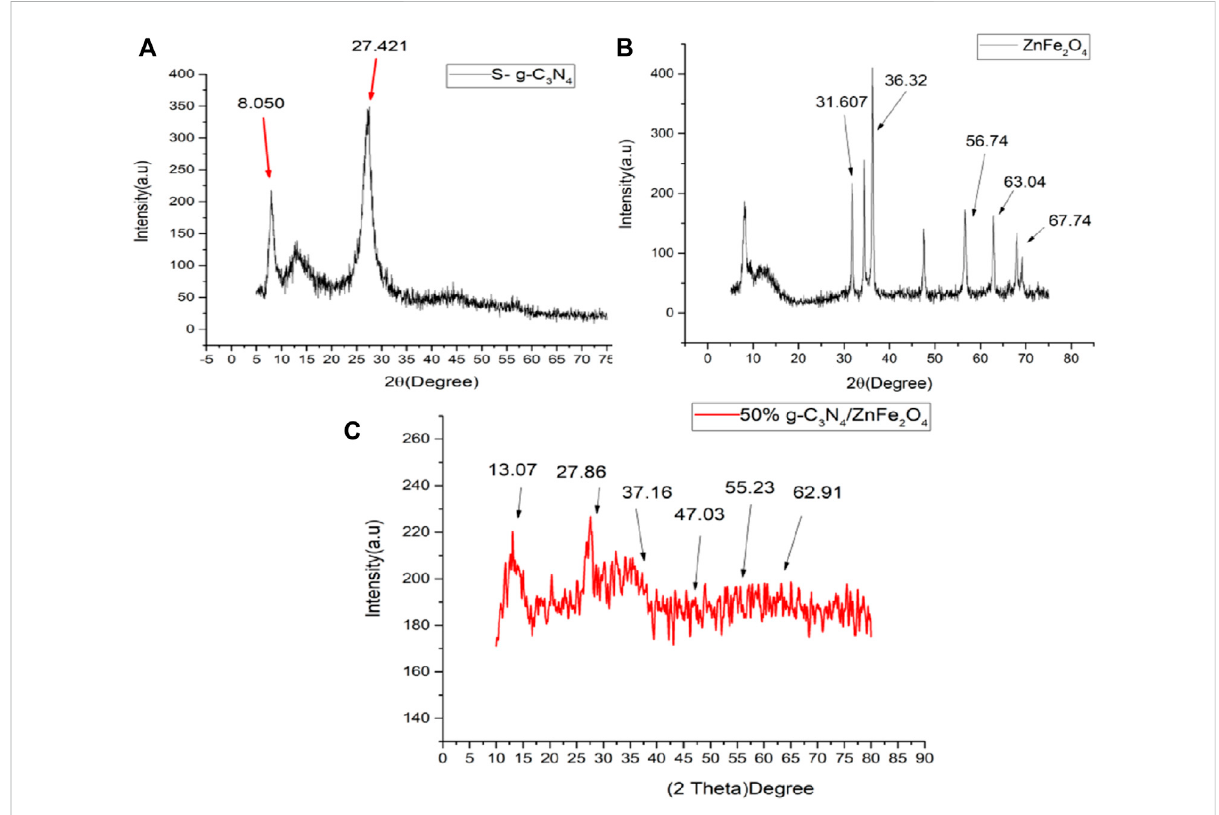
FIGURE 1 XRD pattern of (A) S-doped g-C 3 N 4 , (B) ZnFe 2 O 4 NPs (C) 50% ZnFe 2 O 4 /S-g-C 3 N 4